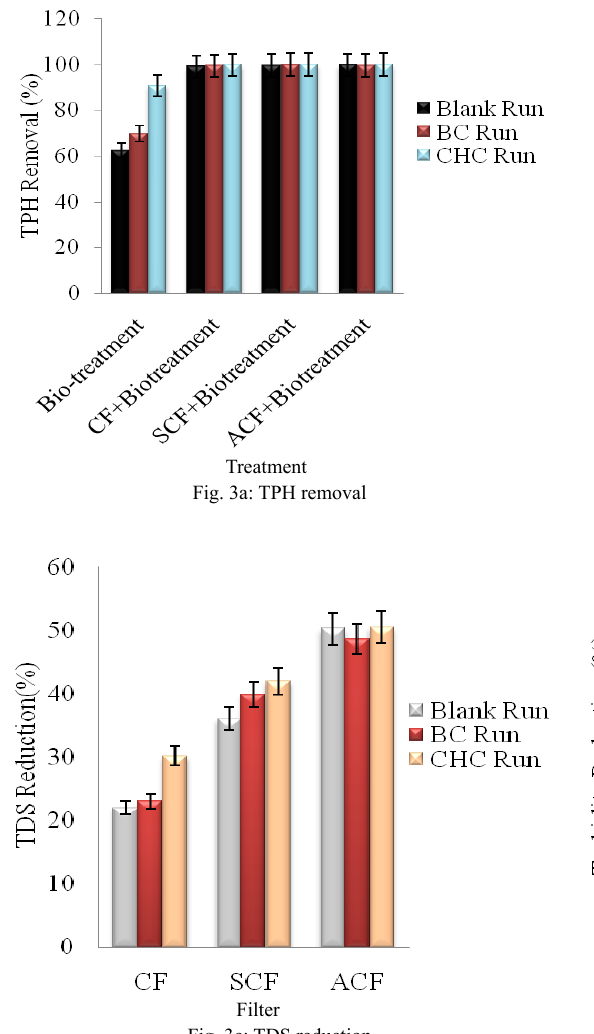
Fig. 3c: TDS reduction Fig. 3d: Turbidity reduction (TR)